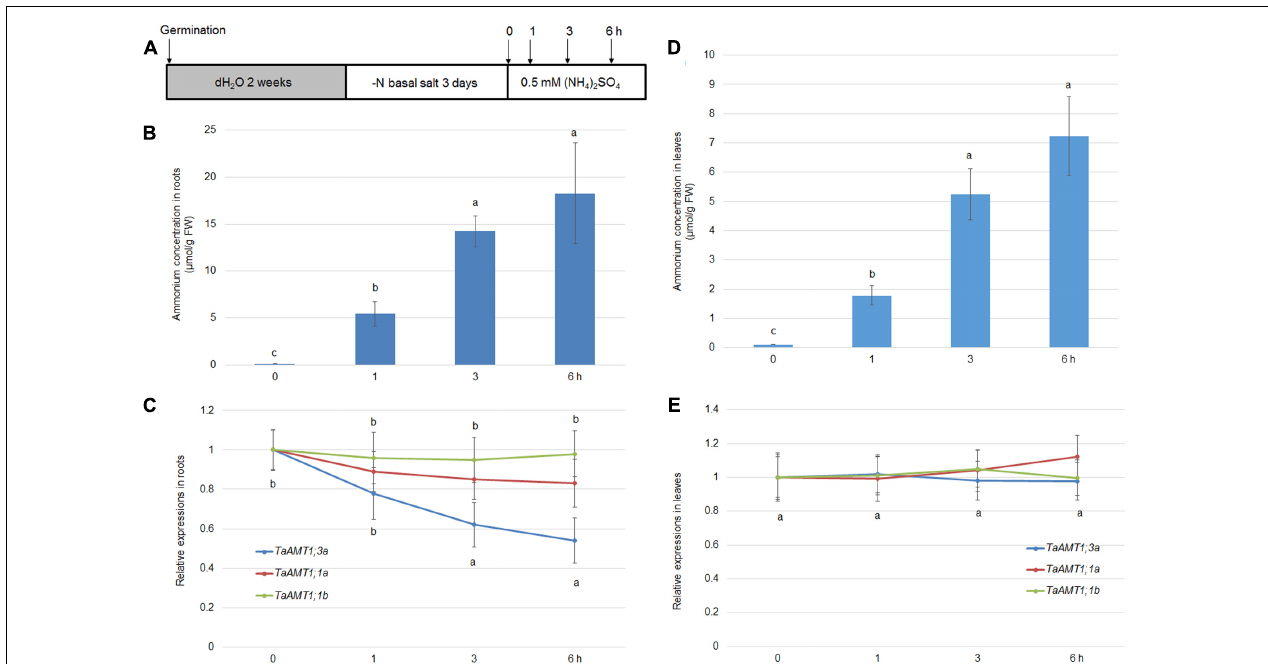
FIGURE 5 | NH + 4 -dependent transcriptional changes in TaAMT1;1 genes. Seventeen-day-old seedlings grown as described in the section “Materials and Methods” were transferred to 0.5 mM (NH 4 ) 2 SO 4 containing solution (pH 5.5). Total roots and leaves of 17-day-old plants were sampled at 0, 1, 3, and 6 h after the addition of NH + 4 (A) . Endogenous NH + 4 levels measured in the roots of 17-day-old plants ( n > 10). Data represent means ± SE ( n = 3) (B) . qRT-PCR was performed to determine the expression levels of TaAMT genes in the roots. The level of TaAMT1;1 genes before NH + 4 treatment was defined as 1. The relative ratio shown is the ratio against 1 (C) . Endogenous NH + 4 levels measured in the leaves of 17-day-old plants. Data represent means ± SE ( n = 3) (D) . qRT-PCR was performed to determine the expression levels of TaAMT genes in the leaves (E) . The levels of TaAMT1;1 genes before NH + 4 treatment was defined as 1. The relative ratio shown is the ratio against 1. qRT-PCR was performed to determine the expression levels of TaAMT1 genes in the roots. The levels of TaAMT1;1 genes before N deprivation were defined as 1. The relative ratio shown is the ratio against 1. Significant differences at P < 0.05 level are indicated by different